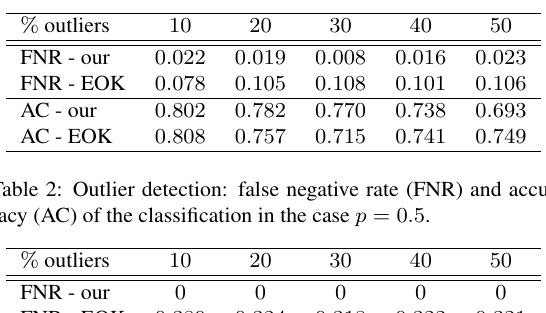
Table 1: Outlier detection: false negative rate (FNR) and accu- racy (AC) of the classification in the case p = 0 . 25 .